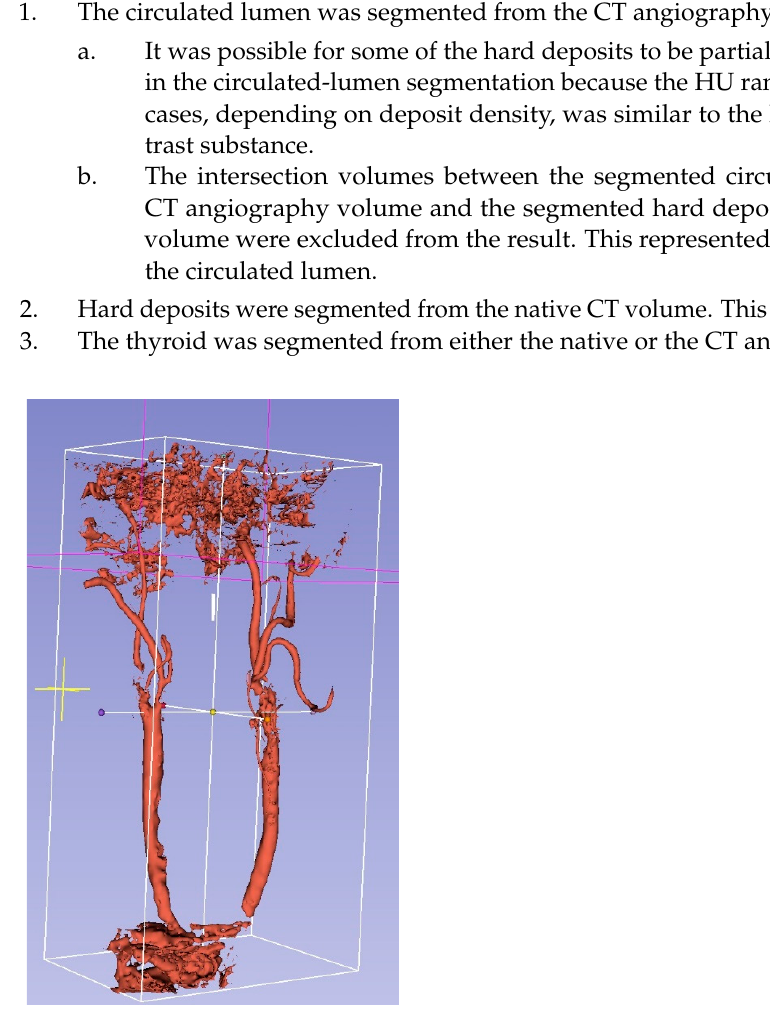
Figure 2. Segmented blood vessels from CT angiography.